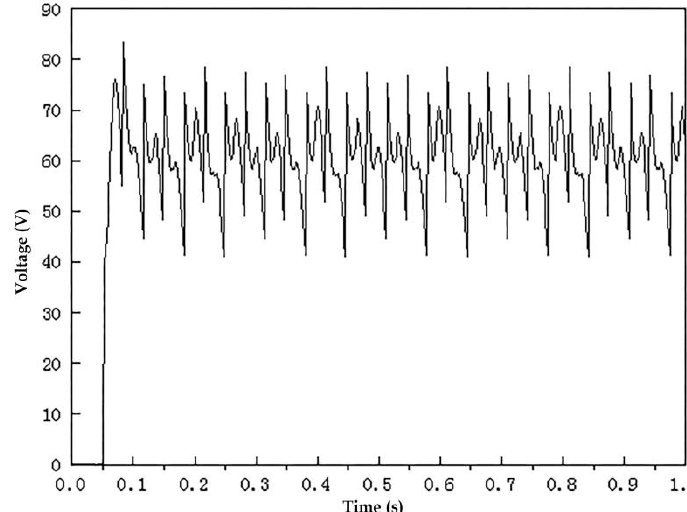
Figure 19. When there is no filter capacitor, the power generation voltage waveform is shown in Figure 19.